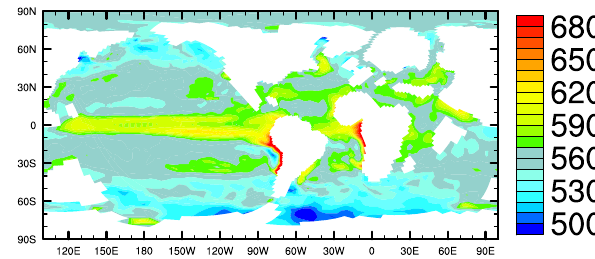
Figure 6. Annual mean surface ocean p CO 2 Fig. 6. Annual mean surface ocean pCO 2 (ppm).